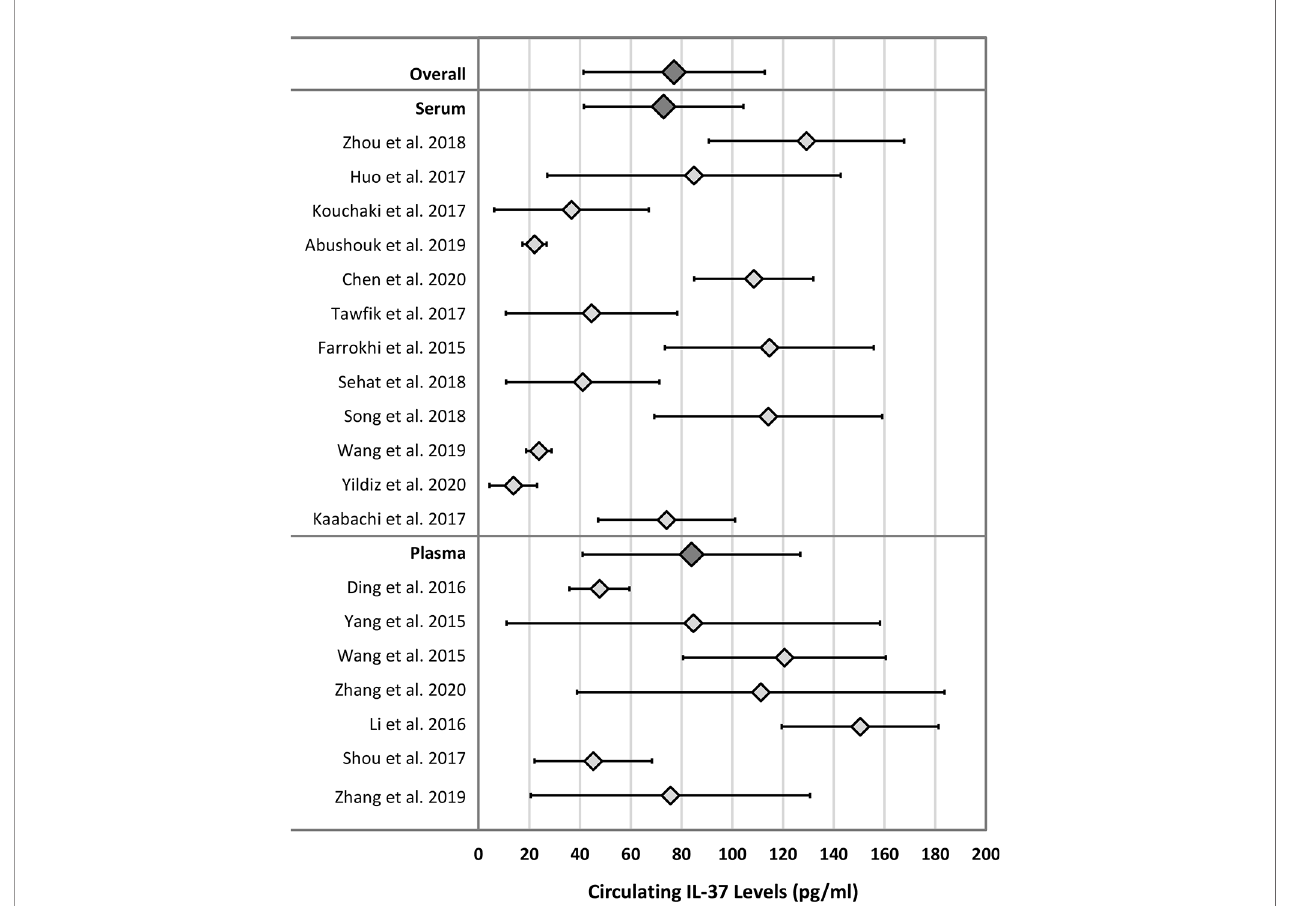
FIGURE 3 | Forest plot of IL-37 means and ranges (± 2 SD) for individual studies and mean of weighted means and reference ranges. Dark grey diamonds: Overall - mean of weighted means and reference range of IL-37 in both serum and plasma matrix; Serum - mean of weighted means and reference range of IL-37 in serum only; Plasma - mean of weighted means and reference range of IL-37 in plasma only.